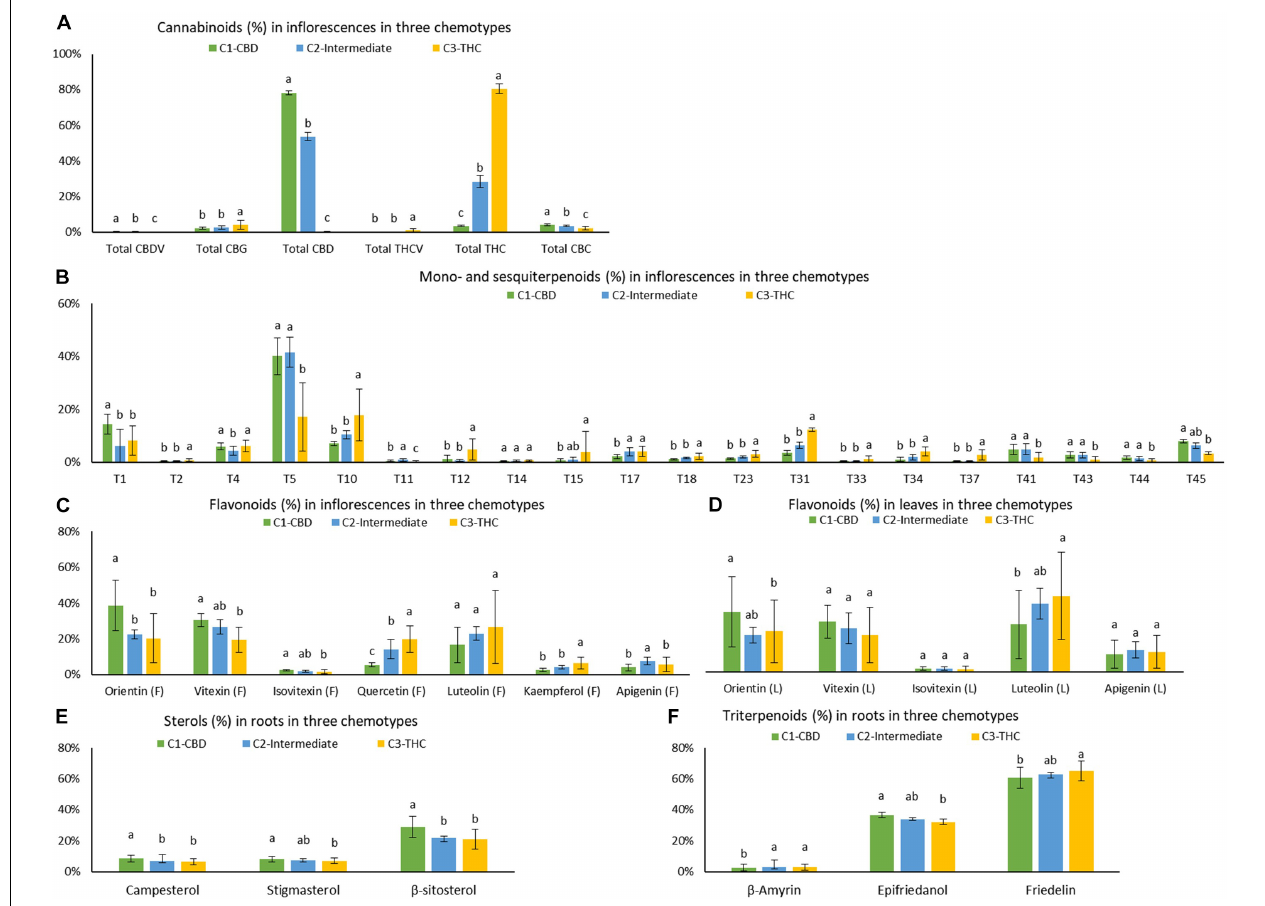
FIGURE 6 | Means and standard deviations ( ± SD) of (A) cannabinoids in inflorescences, (B) mono- and sesquiterpenoids in inflorescences, (C) flavonoids in inflorescences, (D) flavonoids in leaves, (E) sterols in roots, and (F) triterpenoids in roots (in ratios) for each of the three chemotypes C1 – CBD dominant, C2 – intermediate, and C3 – THC dominant. Cluster means were expressed as mean ± SD. *Levels not connected by the same letter are significantly different by Tukey HSD multiple tests at the 0.05 significance